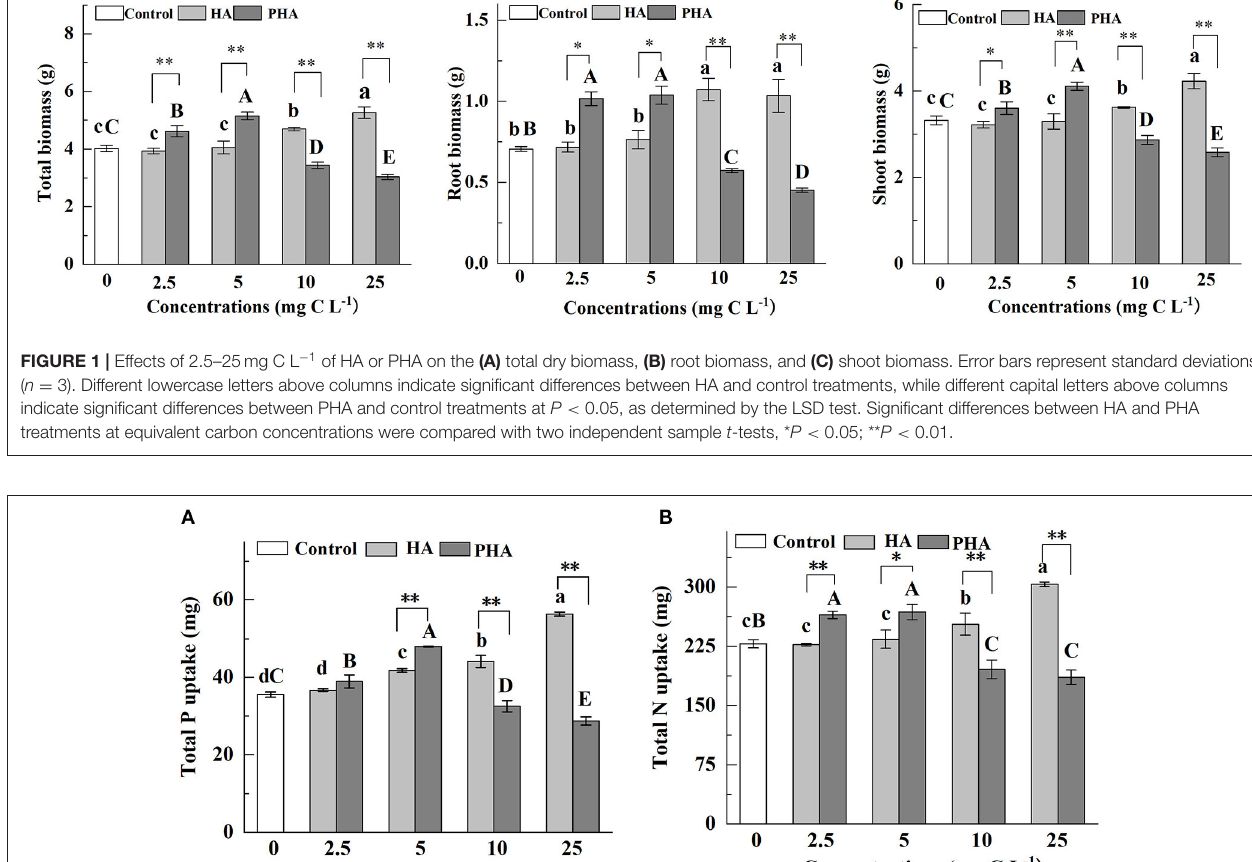
L − 1 ( P < 0.05). These results suggested that the positive effects